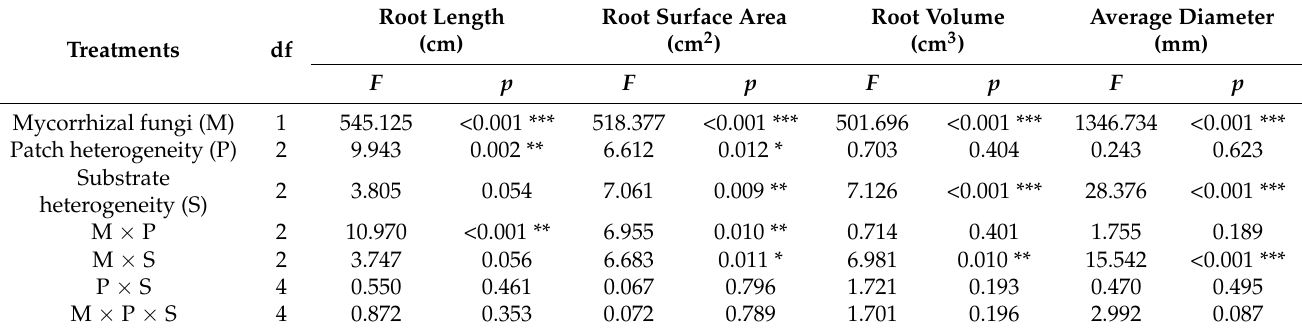
Table 3. Three-way ANOVA for the effect of mycorrhizal fungus (M + vs. M − ), patch heterogeneity (Homo vs. Hetl vs. Hets), and soil substrate heterogeneity (GL vs. GF vs. GH) on root length, surface area, and volume, and average